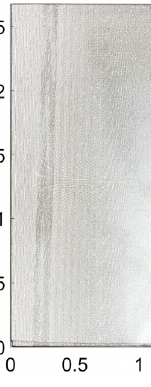
Figure 16. Scanned point cloud—wall no. 8.